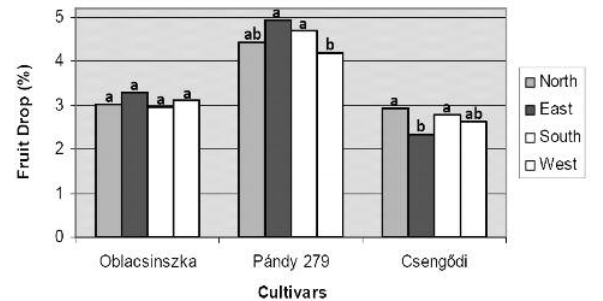
Figure 5C. Fruit drop of sour cherry cultivars on different direction of the